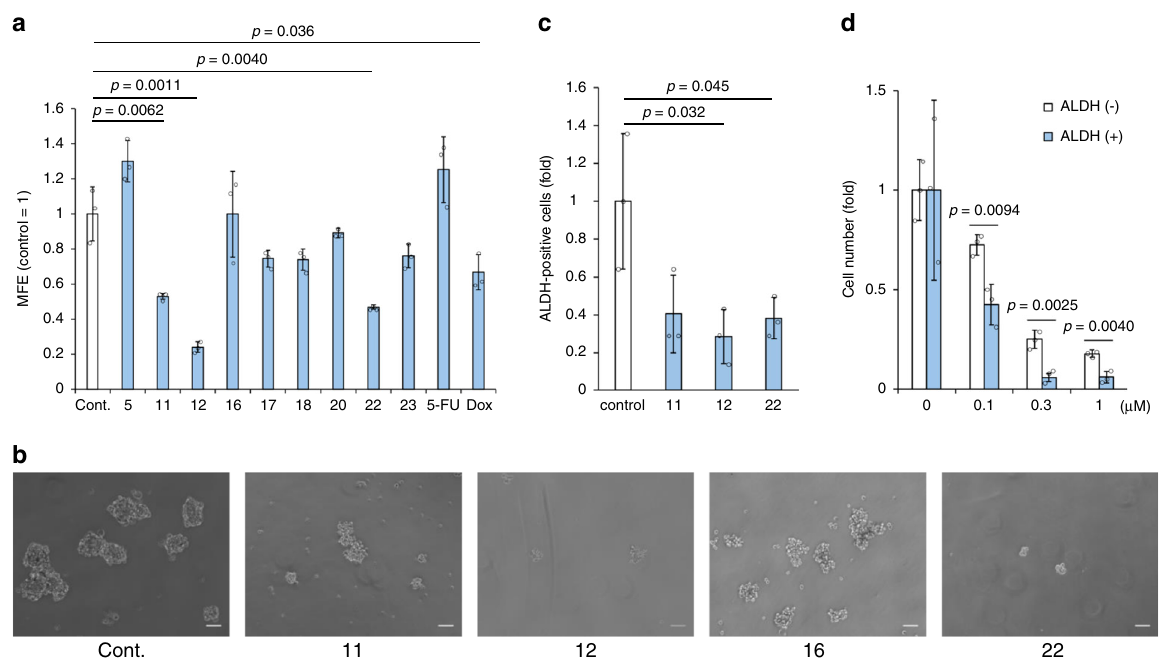
Fig. 5 DDPs show anti-CSC activity in breast cancer cell line MCF-7. a Effect of DDPs on mammosphere formation. After the cells were cultured in the presence of 5 μ M DDPs for 7 days, the number of mammospheres was microscopically counted and the percentage of mammosphere-forming cells was determined as mammosphere-forming ef fi ciency (MFE; %). Data represent mean ± s.d. from three independent replicate experiments. P -values were calculated by a two-sided unpaired Student ’ s t -test, compared with control. b Micrographs show representative images of mammosphere formation from three independent replicate experiments using compound 11, 12, 16, 22 . The scale bar, 50 mm. c Effect of DDPs (1 μ M, 3 days) on ALDH-positive cells in MCF-7 cells. Data represent mean ± s.d. from three independent replicate experiments. P -values were calculated by a two-sided unpaired Student ’ s t -test, compared with control. d Dose-dependent effect of compound 12 on ALDH-positive cells in MCF-7 cells. Data represent mean ± s.d. from three independent replicate experiments. P -values were calculated by a two-sided unpaired Student ’ s t -test. Source data underlying Fig. 5a, c, d are provided in a Source Data fi